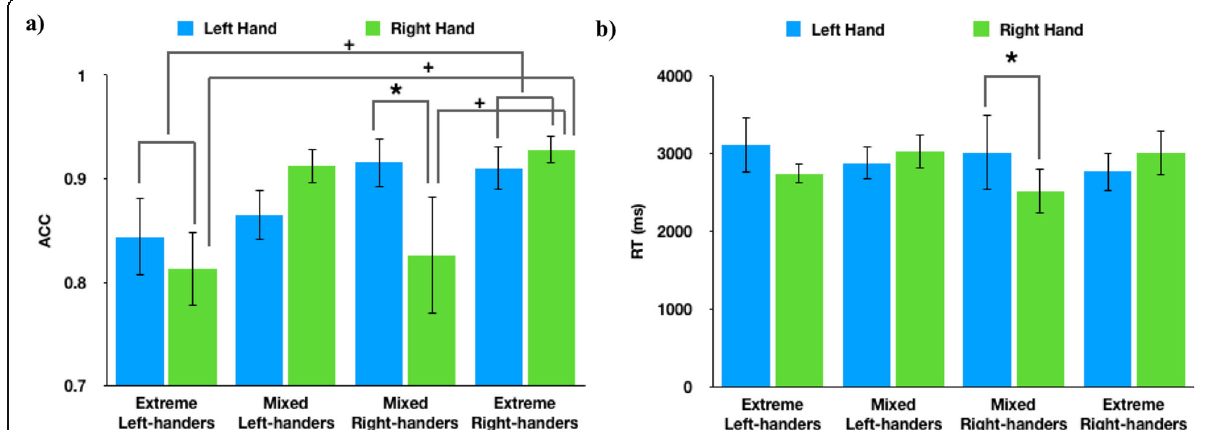
Fig. 5 Performance for same-hand stimuli/same-gesture trials. Significance levels labeled in the figure are based on the handedness direction× handedness strength×hand stimuli tested three-way analysis of variance among all subjects. a Accuracy for same-hand stimuli/same-gesture trials. Mixed right-handers had significantly higher accuracy for left-hand stimuli than for right-hand stimuli (supports Hypothesis 3 or 4). Extreme right- hander ’ s accuracy was marginally higher than extreme left-handers (does not support any hypothesis). Extreme right-handers had marginally higher accuracy than mixed right-handers and extreme left-handers for right-hand stimuli (both support Hypothesis 2). In addition, mixed left-handers had a trend for higher accuracy for right-hand stimuli than for left-hand stimuli (supports Hypothesis 1 or 4). Mixed left-handers also had a trend for higher accuracy for right-hand stimuli than mixed right-handers (supports Hypothesis 4). b Reaction time for same-hand stimuli/same-gesture trials. Mixed right-handers responded faster for right hands than for left hands (supports Hypothesis 1 or 2). ACC Accuracy; RT Reaction time; + p < .1; * p < .05